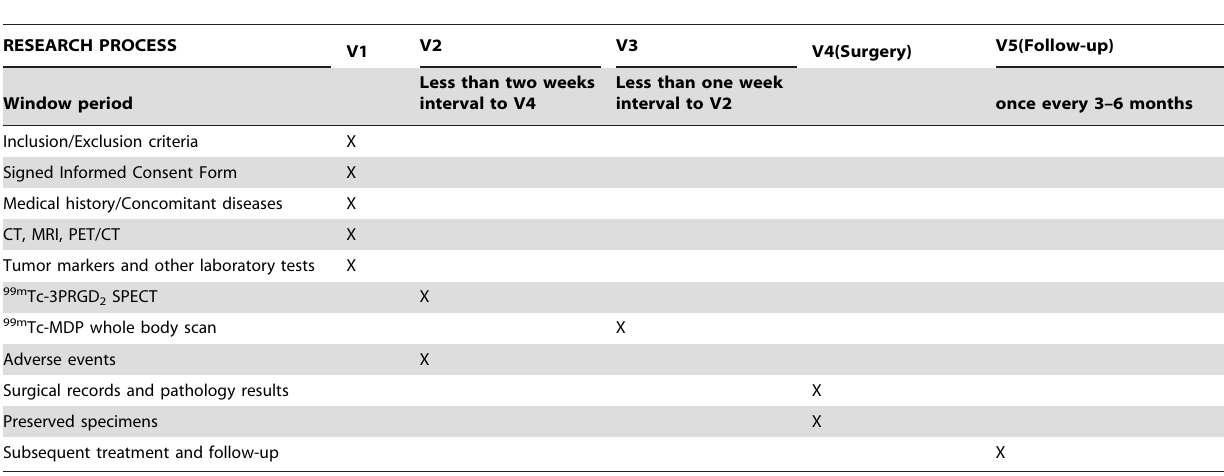
Table 2. Flowchart of the study.